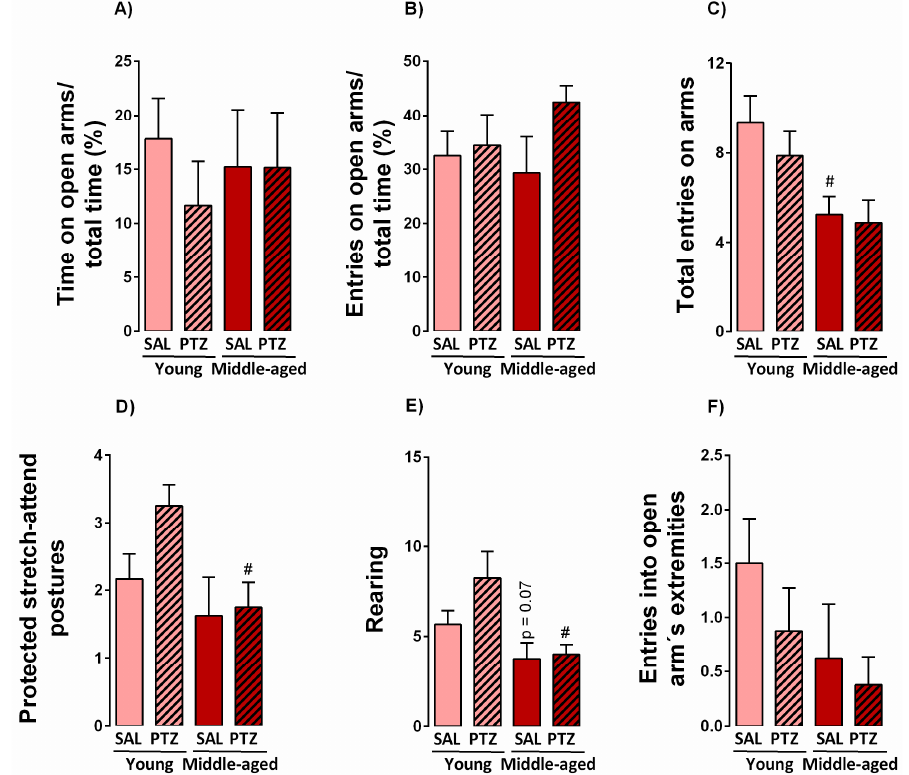
Figure 2. Effects of aging on anxiety-like behaviors of aged kindled rats evaluated in the elevated plus-maze test. Values are represented by the mean + S.E.M. followed by two-way ANOVA (A) and Newman-Keuls post-hoc test when required. # p < 0.05 in the comparison between kindled groups ( n = 8–12/group).